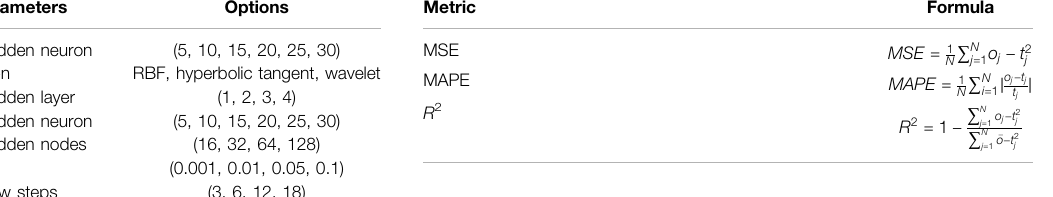
TABLE 1 | Summary of the hyperparameters of the algorithms tested. Algorithm Hyperparameters Options